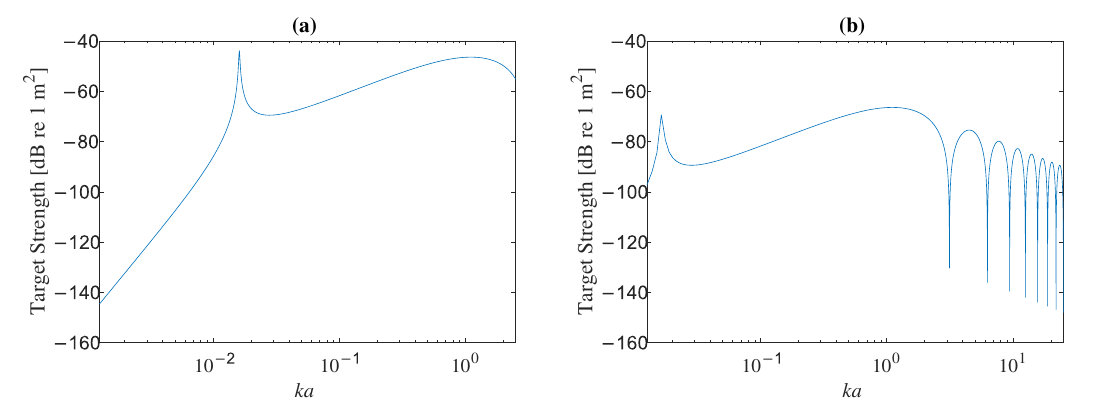
Figure 1. Target strength of a single gas bubble under ( a ) a relatively small ka value and ( b ) a relatively large ka value.